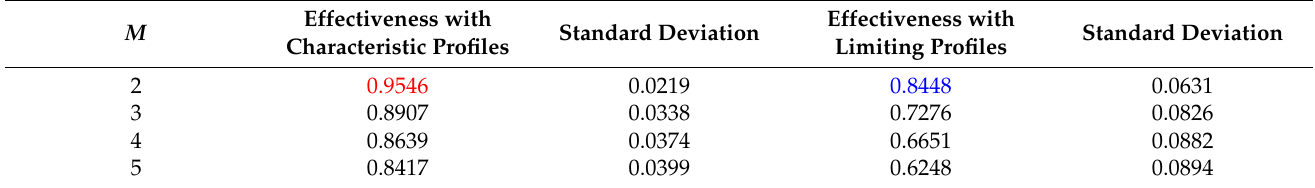
Table 4. Out-of-sample effectiveness of both types of methods regarding the number of classes.